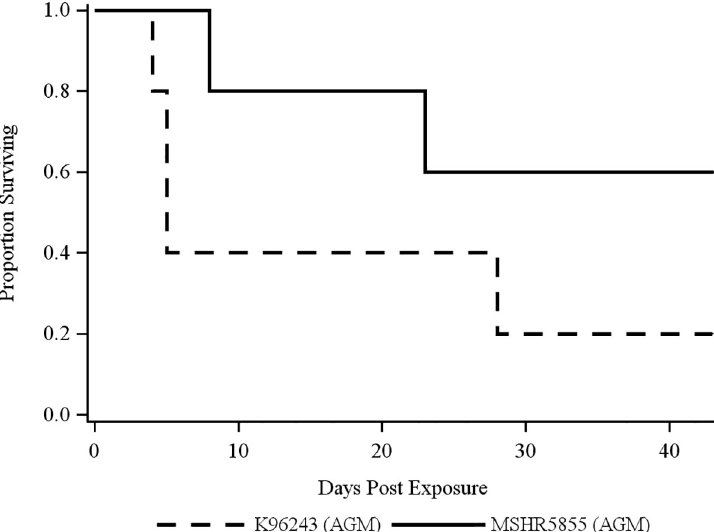
Fig 3. Survival curves of AGMs challenged with aerosolized B . pseudomallei MSHR5855 and K96243. AGMs were aerosolized with an average dose of 206 CFU (range 114–299) of B . pseudomallei MSHR5855 or 1047 CFU (range 820– 1530) of B . pseudomallei K96243. There was no significant difference in survival times between these two strains of B . pseudomallei by log-rank test ( p =